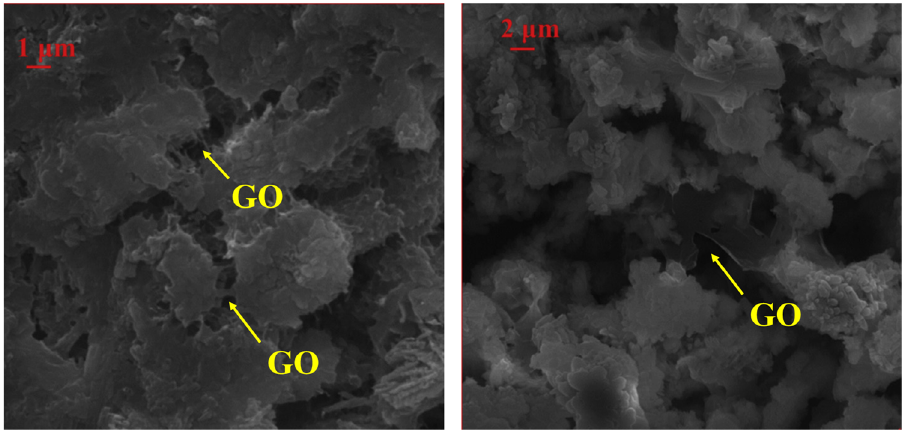
Figure 10: SEM images of GO nanosheet - modi fi ed